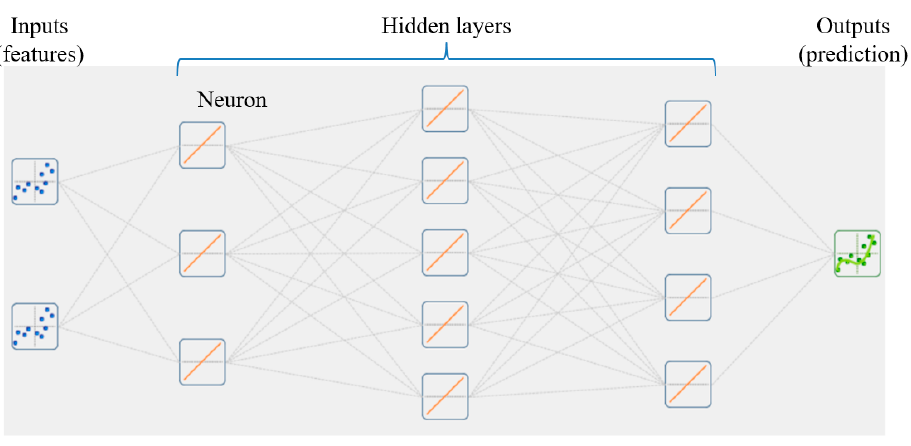
Figure 6. Structure of MLP.